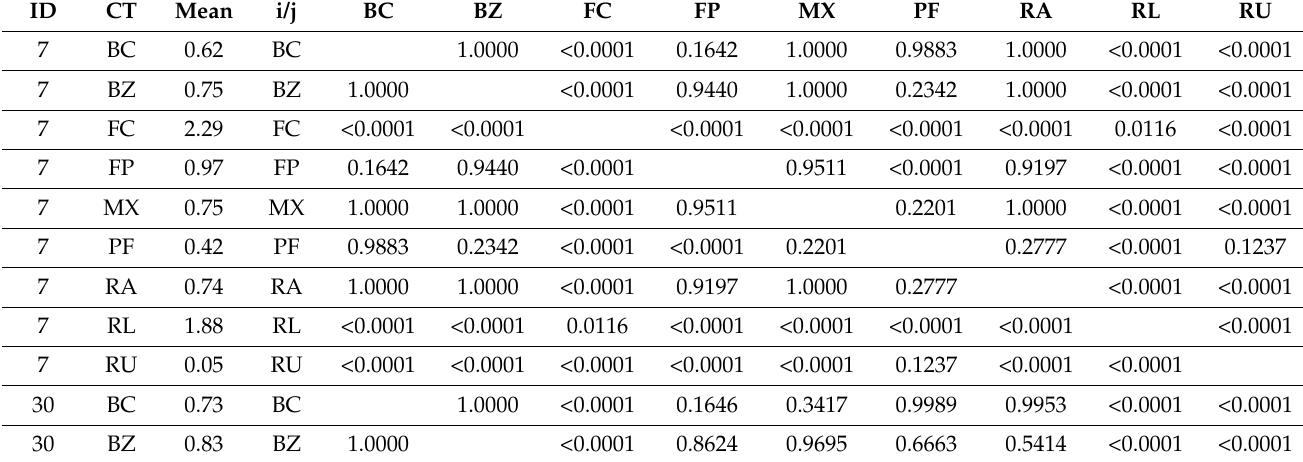
Table 9. Statistical comparison of WSL (%) among different cement types in a specific immersion duration subgroups. (Pair-wise comparisons within immersion duration; Tukey adjusted p